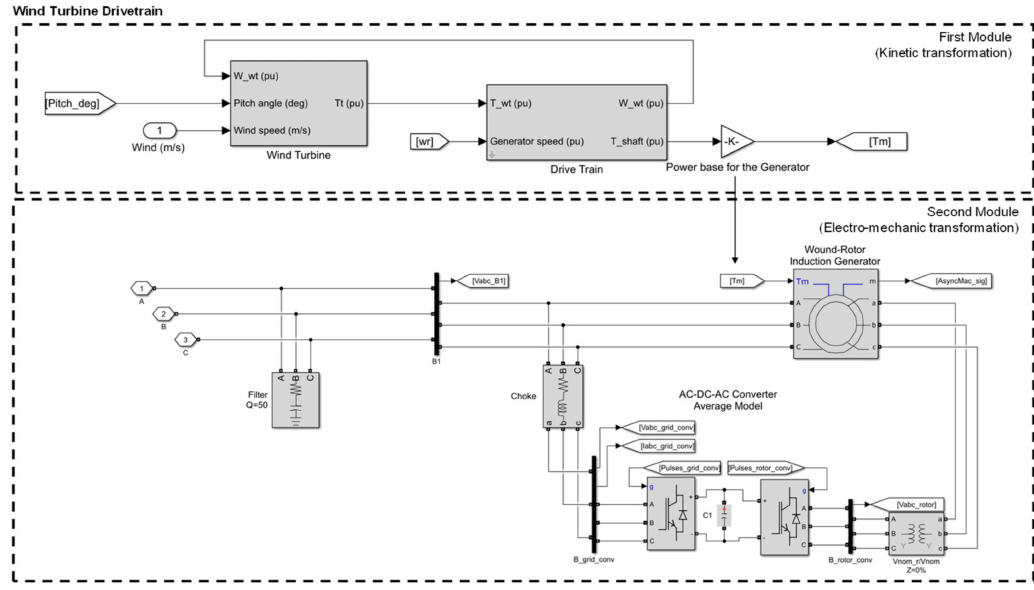
Figure 9. Wind turbine drivetrain physics-based model representation in